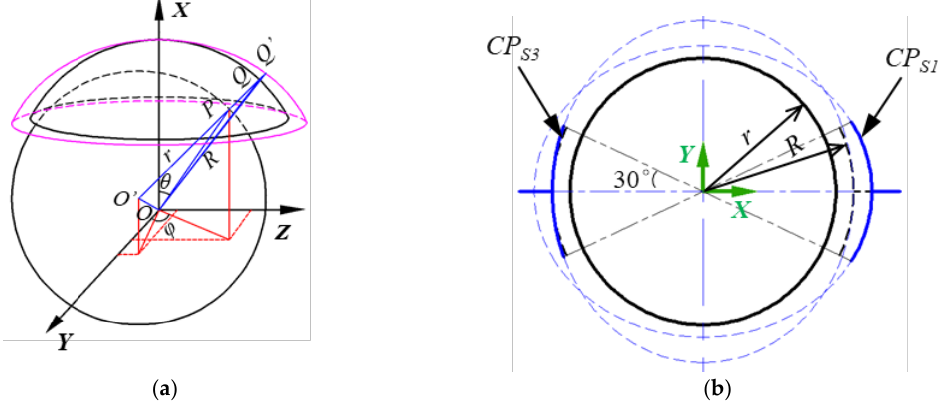
Figure 3. Sketch of the clearance between the spherical ball and the ellipsoidal plates. ( a ) 3D sketch, ( b ) 2D projection in the XOY plane.